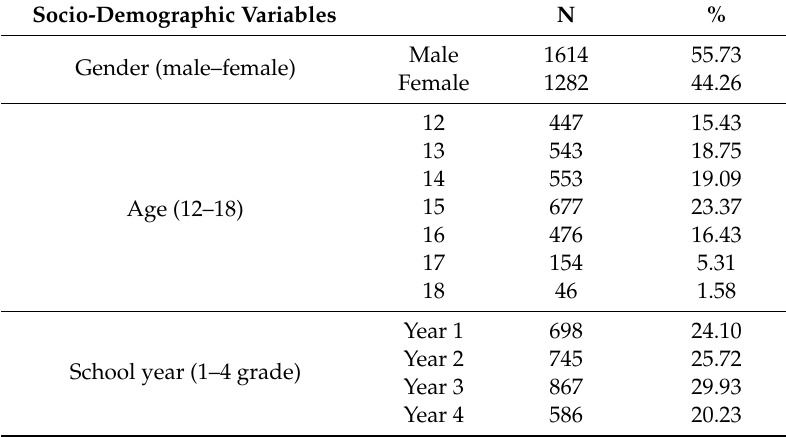
Table 1. Socio-demographic data by variables of gender, age, and school year.